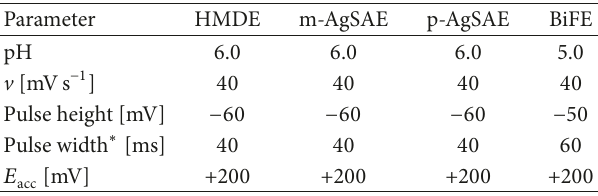
Table 1: Optimized DPV parameters for DAN